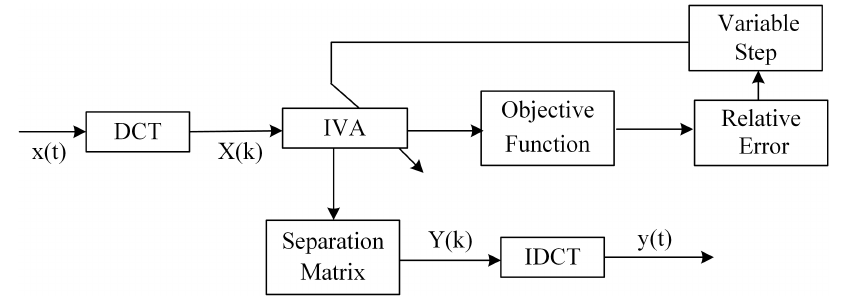
Figure 2. Block diagram of the DCT-G-IVA method.